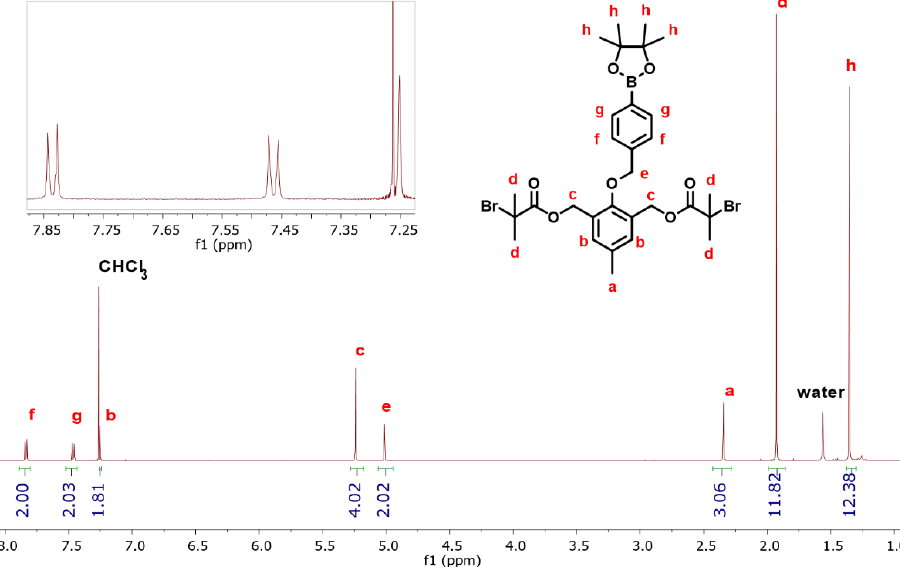
Figure 2. 1 H-NMR spectrum of the difunctional initiator (DFI) compound 4 in CDCl 3 .